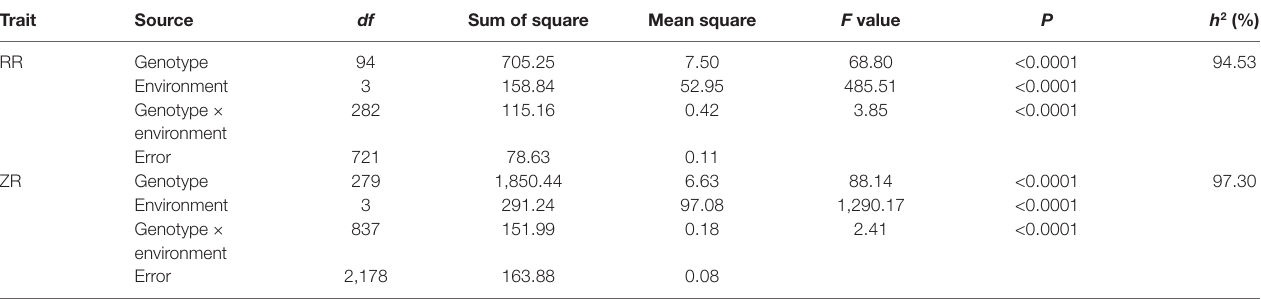
TaBLe 2 | ANOVA and broad-sense heritability ( h 2 ) of silique length (SL) in RR and ZR populations.